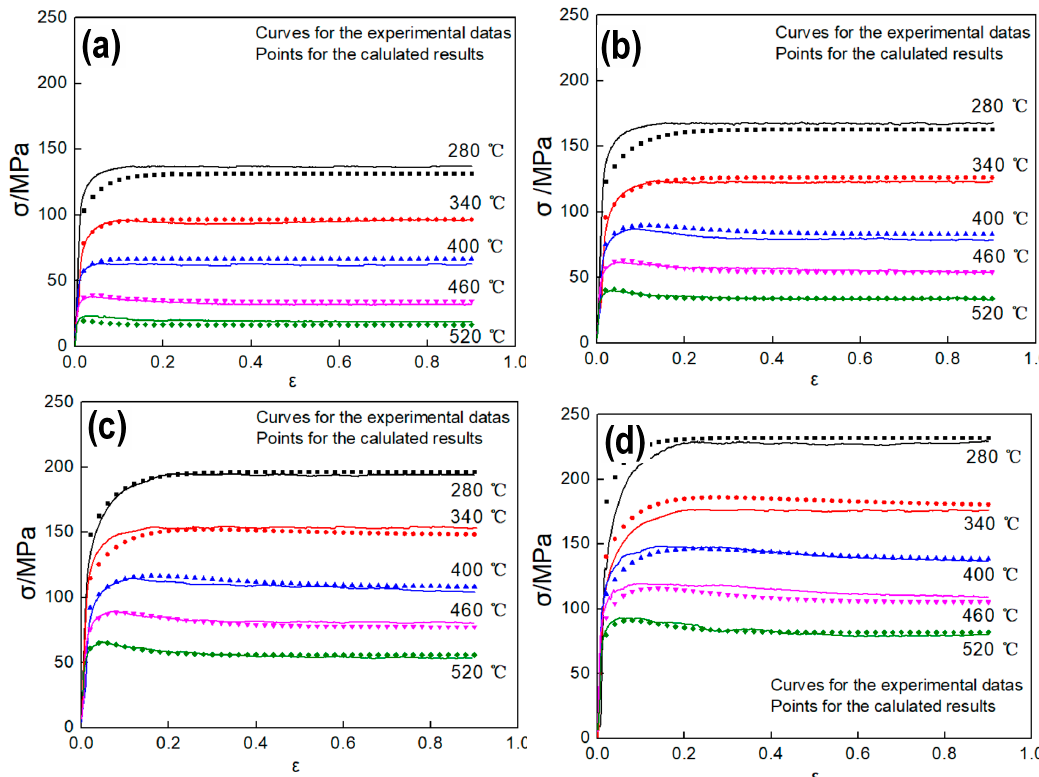
Figure 12. Comparison between the experimental and predicted flow stress curves. ( a ) 0.01 s − 1 , ( b ) 0.1 s − 1 , ( c ) 1 s − 1 , ( d ) 10 s − 1 .